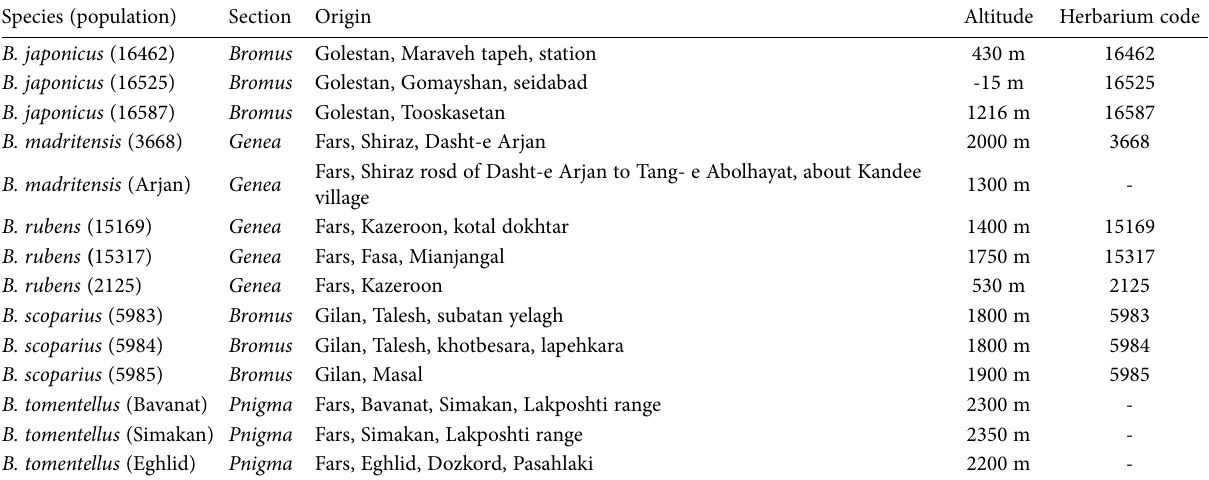
Table 1. The origin of materials used in chromosome studies of Bromus. Species (population) Section